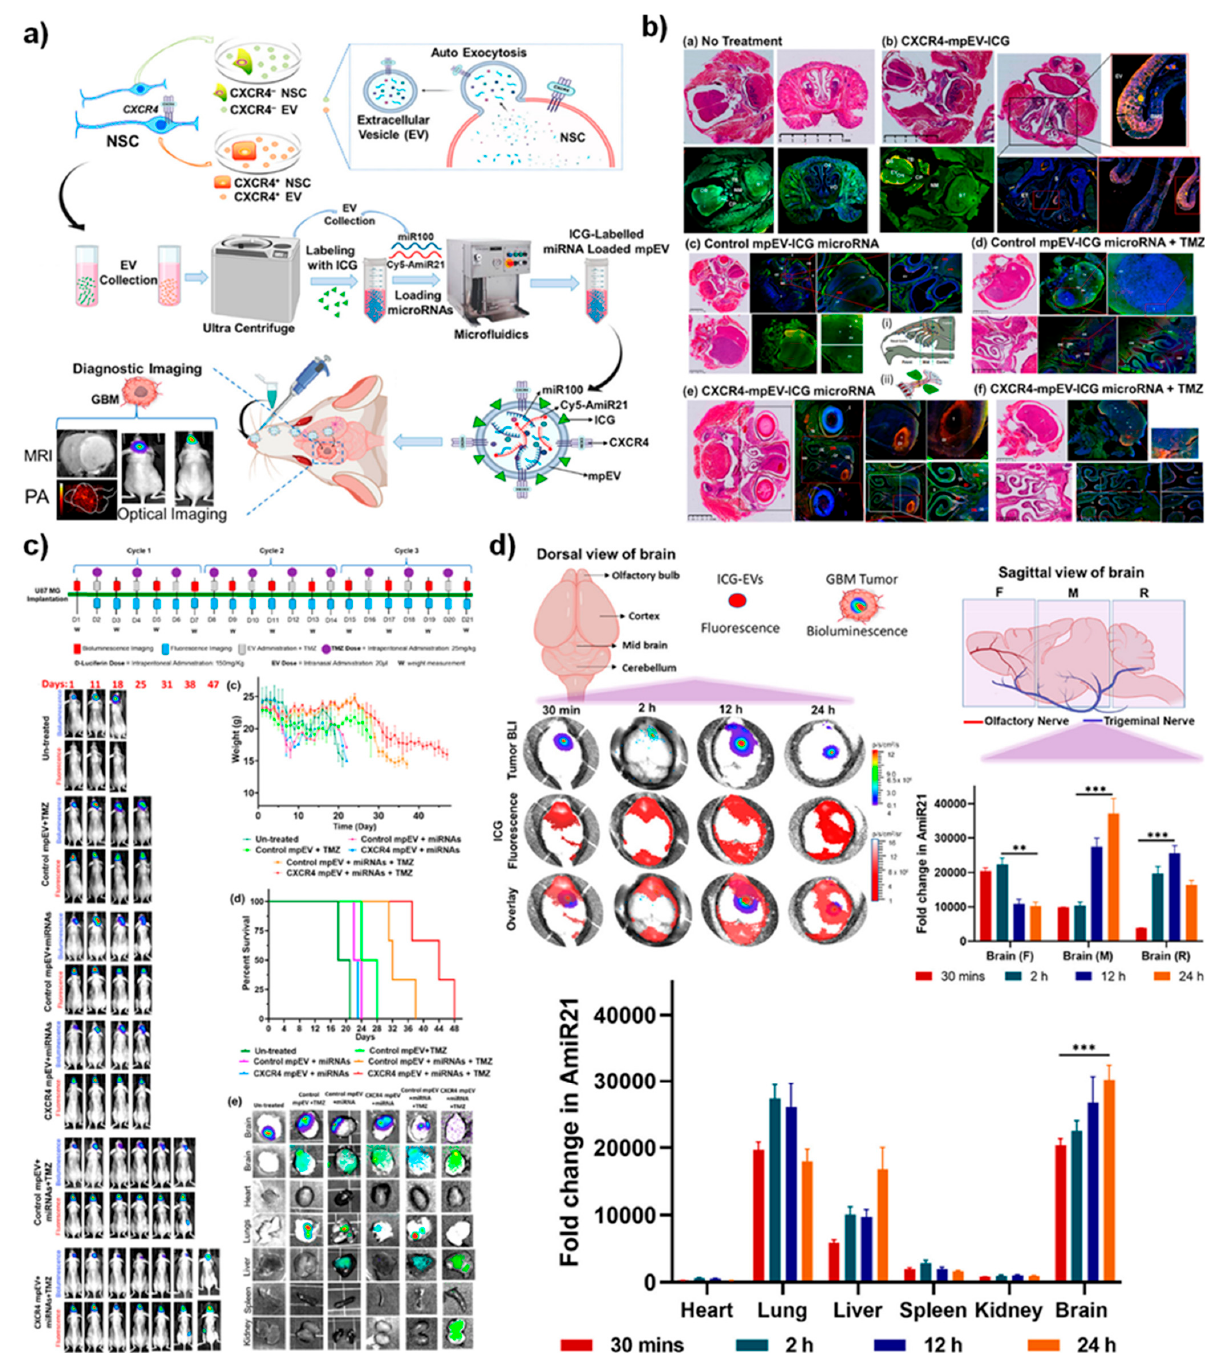
Figure 5. ( a ) Schematic illustration explains the microfluidic reconstruction of miRNA-loaded extracellular vesicles (EVs) for intranasal delivery towards the enhancements of theranostic imaging in glioblastoma tumor-bearing mice model. ( b ) H&E and confocal laser scanning immunohistochemical images of cranial sections of animals treated with IN delivered EVs and ( c ) corresponding therapeutic monitoring of IN delivered EVs associated targeted nanomaterial platform with respective control groups, in co-treatment with temozolomide in vivo. ( d ) Diagrammatic and sagittal views of the brain delivered with EVs associated nanomaterials by ex vivo bioluminescence and fluorescence imaging showing intranasal administration at varied time-points in vivo. Shown data represents mean ± S.E.M; *** p < 0.001, ** p < 0.01. Reprinted with permission from Ref. [68]. Copyright 2021 American Chemical